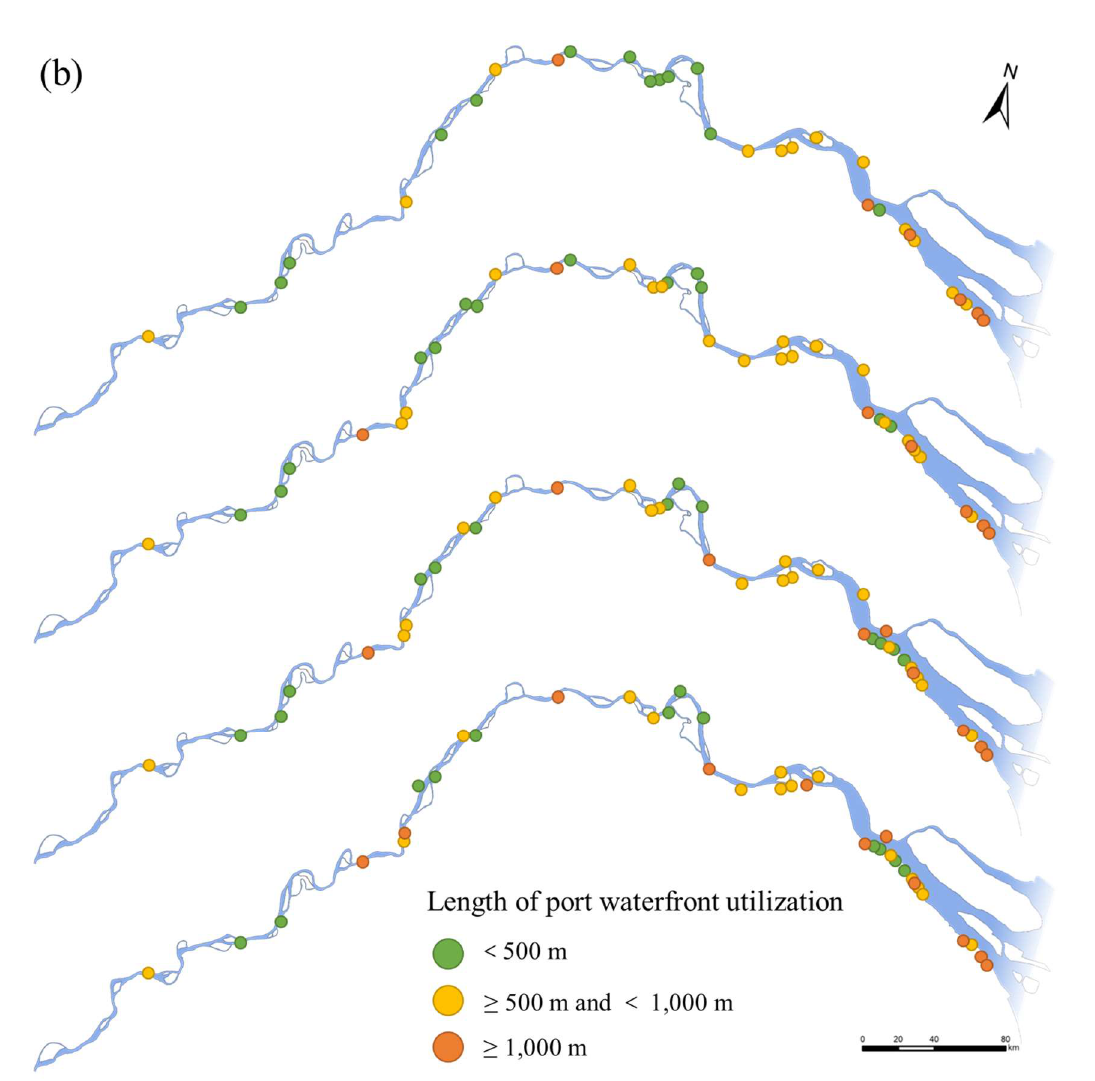
Figure 3. Distribution of Yangtze container ports and length of their waterfronts’ utilization in the Yangtze River Delta. ( a ) the number of container ports and the length of waterfront utilization in cities, ( b ) distribution of container port waterfronts.